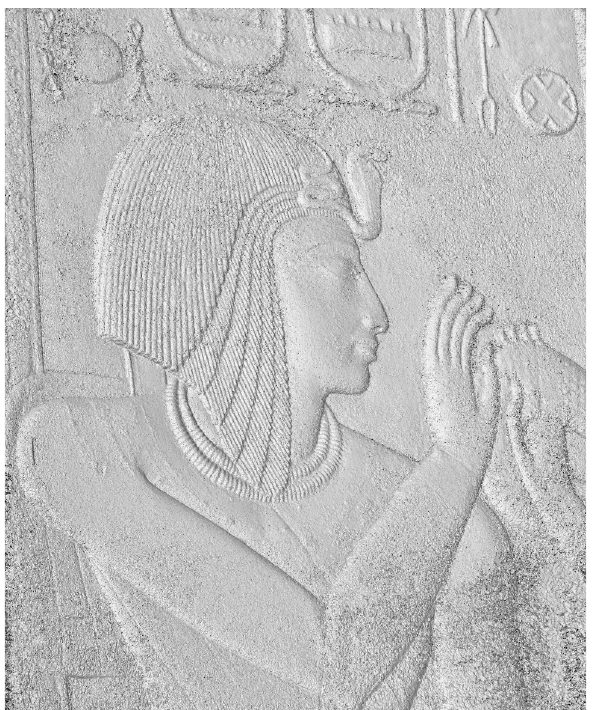
Figure 6. Detail of the dense points-cloud taken from the decorated surface, with the King Seti figure.